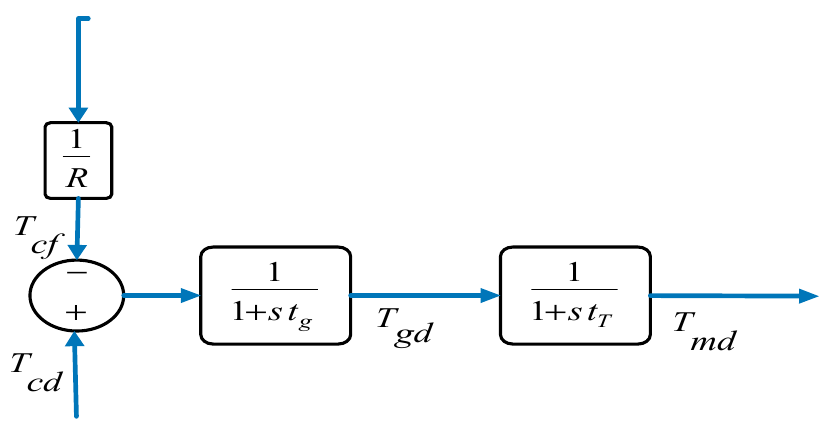
Figure 2. Model of the diesel engine generator (DEG) system.